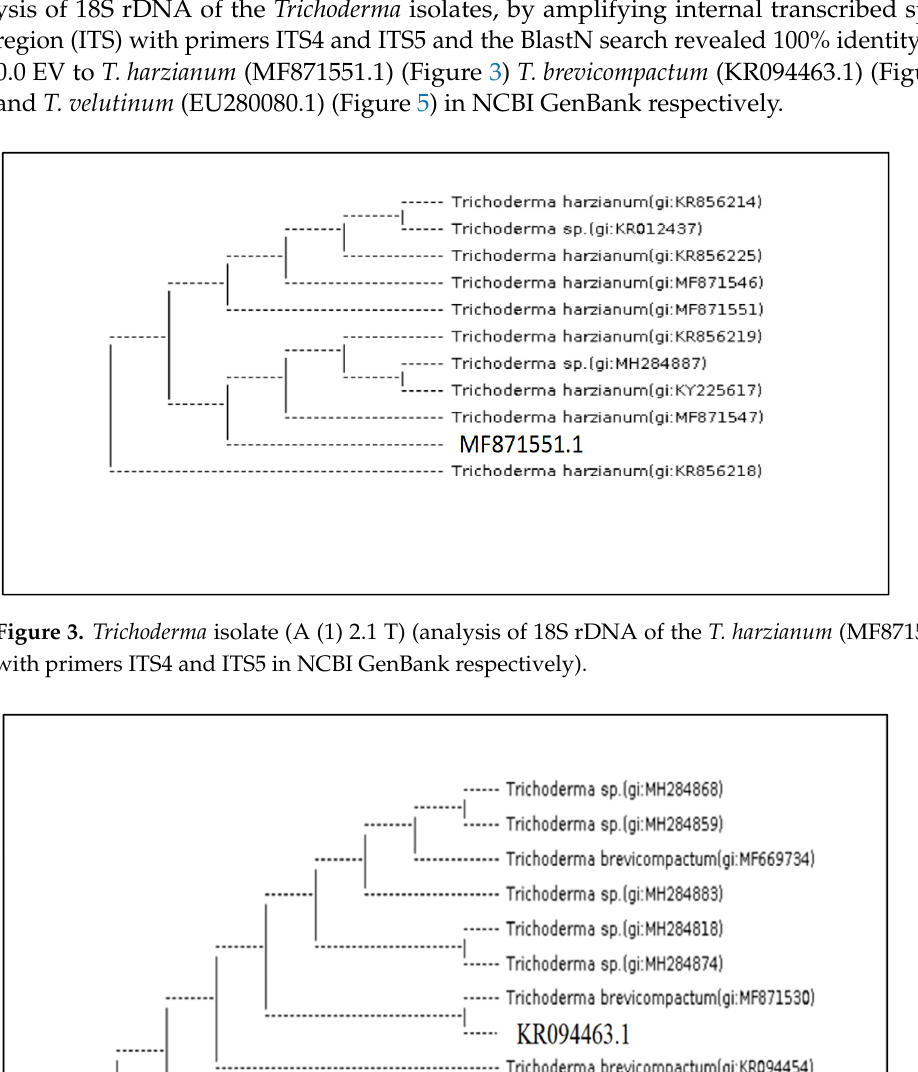
The molecular identification of the most potential Trichoderma isolates (A (1) 2.1 T), (A (3) 3.1 T) and (A (6) 2.2 T) by ITS 4 and ITS 5 showed that they were Trichoderma harzianum, Trichoderma brevicompactum and Trichoderma velutinum , respectively. The analysis of 18S rDNA of the Trichoderma isolates, by amplifying internal transcribed spacer region (ITS) with primers ITS4 and ITS5 and the BlastN search revealed 100% identity with 0.0